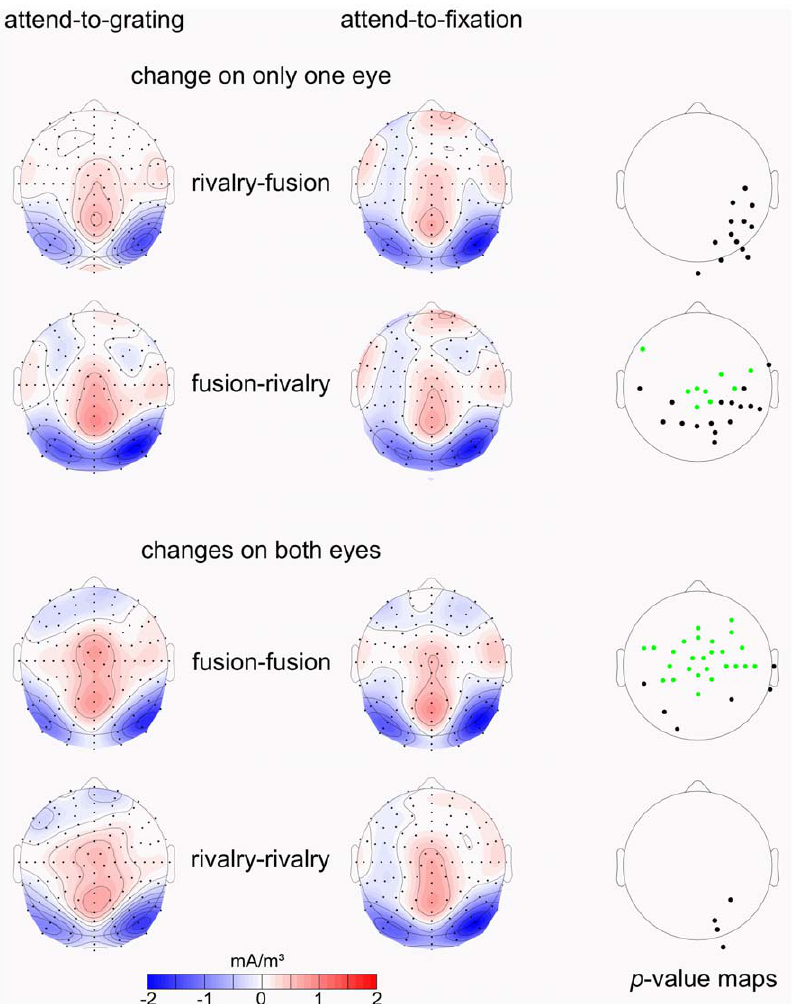
Figure 5. Scalp current density (SCD) maps of the N1 component from the attend-to-grating condition (left) and from the attend- to-fixation condition (middle) for transitions that involve an orientation change on only one eye (rivalry–fusion, fusion–rivalry) and for transitions that involve orientation changes on both eyes (fusion–fusion, rivalry–rivalry). The right column depicts p -value maps for the statistical comparison of SCD values between the attend-to-grating and the attend-to-fixation condition by means of t -tests. P -values are Bonferroni corrected for the number of electrodes ( a =0.05). Green dots mark electrodes for which the current was significantly stronger in the attend-to-grating than in the attend-to-fixation condition. Black dots mark electrodes for which the current was significantly stronger in the attend-to-fixation than in the attend-to-grating condition. Note, that at posterior electrodes for all transitions the current was stronger in the attend-to-fixation condition.